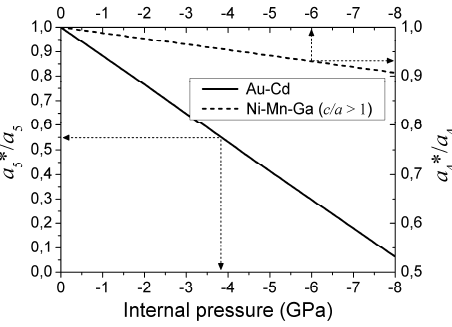
Figure 12. Influence of internal pressure on the coefficient of the third-order energy term, which predetermines the first-order character of martensitic transformation in the rhombohedral Au-Cd martensite and tetragonal Ni-Mn-Ga martensite, considered in